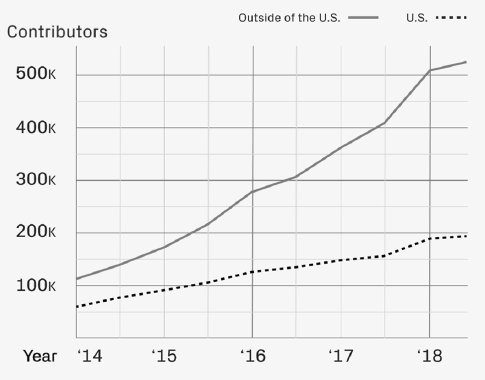
Figure 1. Rising popularity in GitHub from 2014 to 2018. (https://github.blog/2018-11-08-100m- repos/) (accessed on 18 December